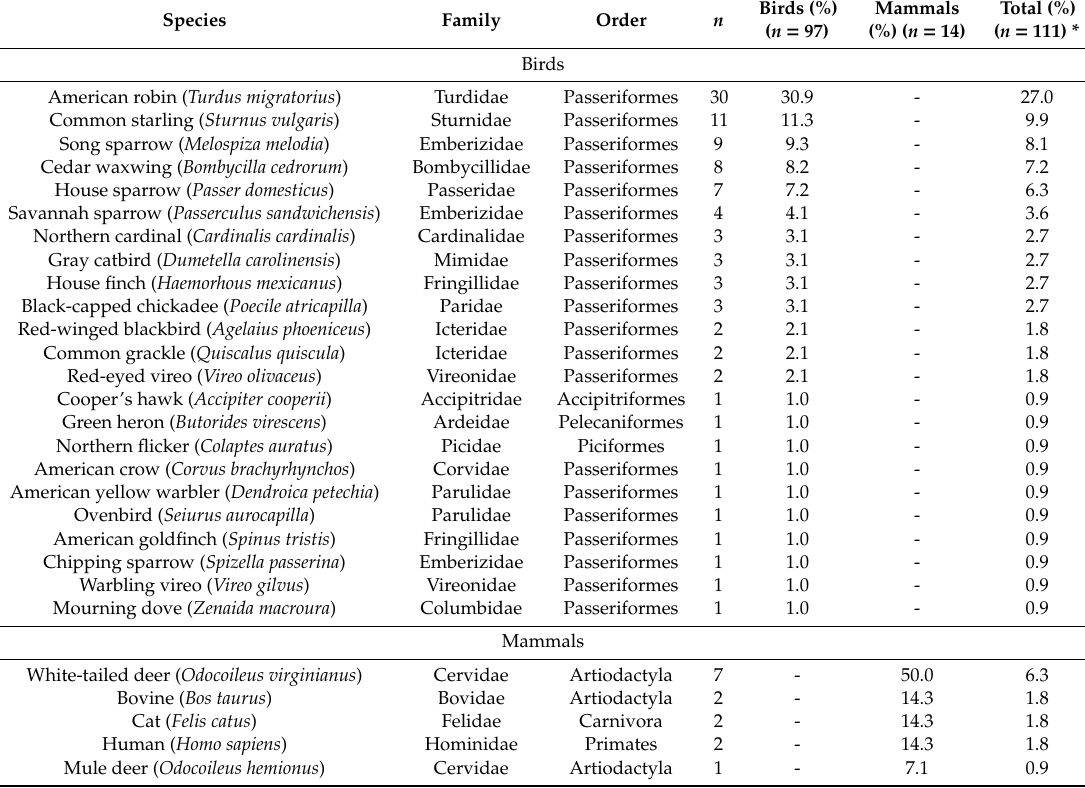
Table 2. Results of the molecular analysis of blood